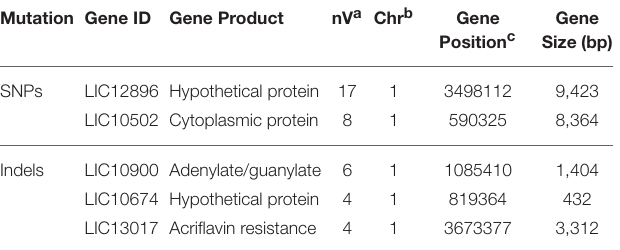
TABLE 2 | Identification of genes showing multiple SNPs and Indels in L. interrogans serovars Copenhageni and Icterohaemorrhagiae. Mutation Gene ID Gene